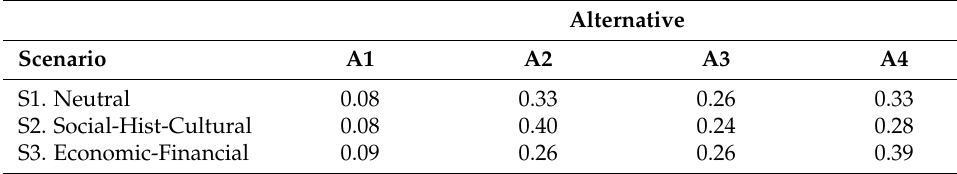
Table 2. The AHP: ranking